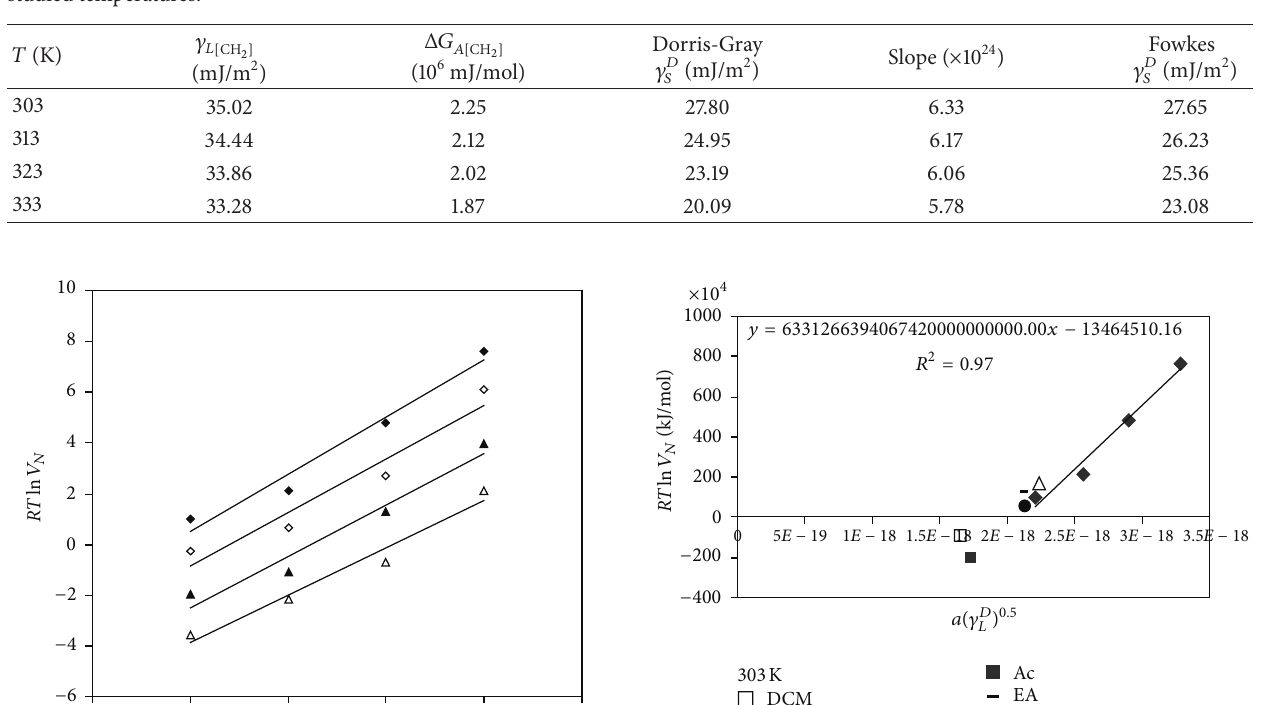
, the surface free energy of a surface consisting of methylene groups, 𝛾 𝐿[ CH 2 ]